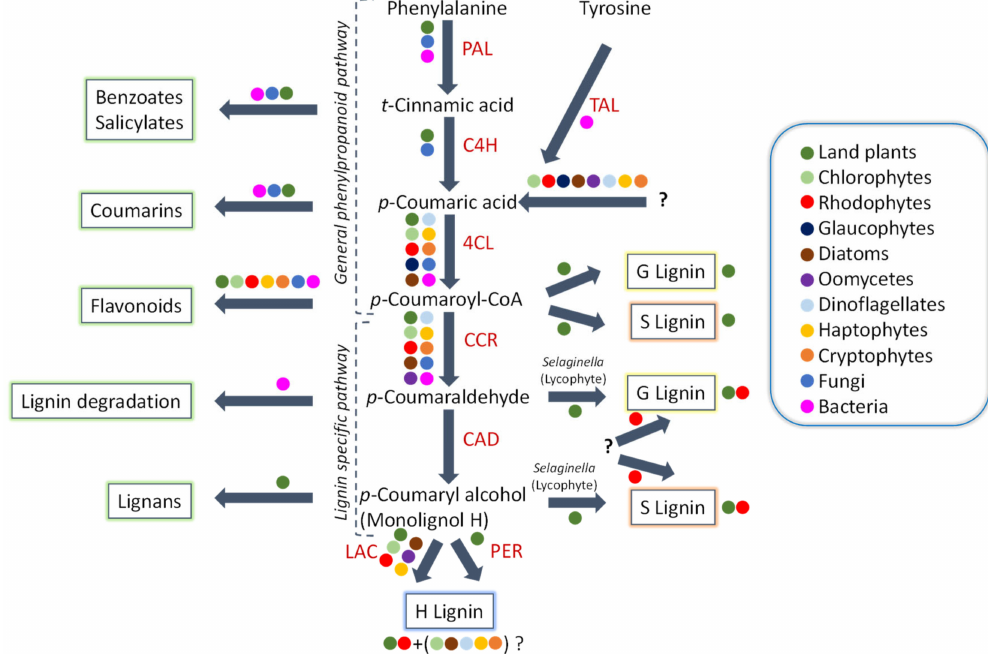
Figure 2. The lignin biosynthesis pathway. Colored dots represent the presence of a given enzyme in a specific taxonomic group. The abbreviations used for the enzyme are: phenylalanine ammonia-lyase; cinnamate 4-hydroxylase (C4H); 4-coumarate:CoA ligase (4CL); cinnamoyl-CoA reductase (CCR); cinnamyl alcohol dehydrogenase (CAD); peroxidase; and laccase (LAC). Question marks (?) signify that the enzyme responsible for the particular function or its substrate is still uncertain, or that the occurrence of a particular compound in a given taxonomic group is suspected but has not been